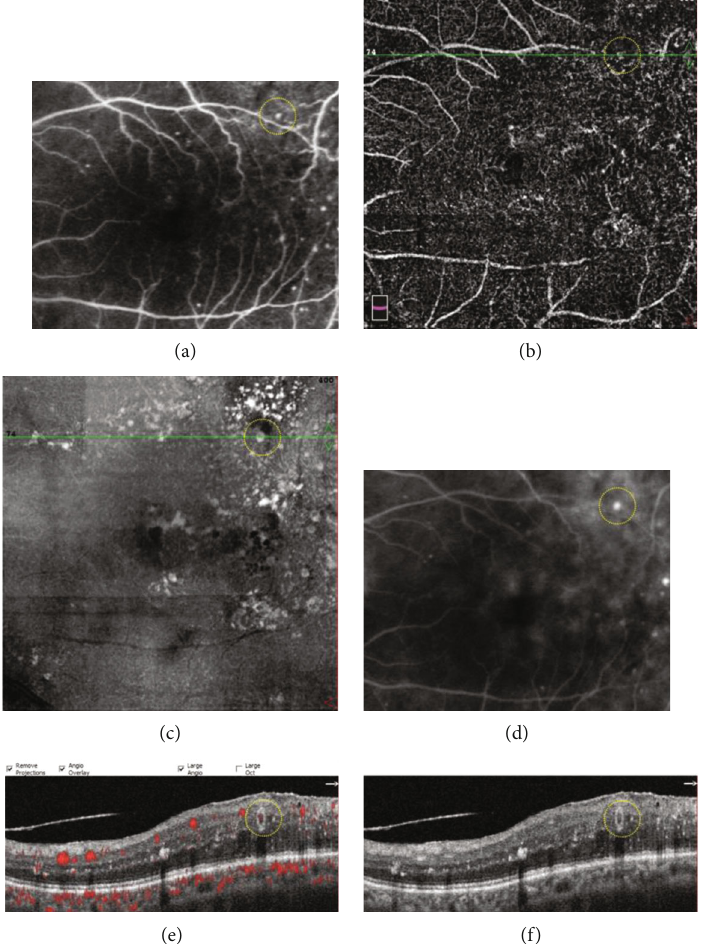
Figure 3: A typical diabetic microaneurysm with mild leakage on FA (yellow circle (a), early phase of FA (d), late phase of FA). The microaneurysm was visualized as comma-like type in OCTA en face image (yellow circle (b)). On OCT en face image, the microaneurysm appeared as a luminescent spot (yellow circle (c)). The microaneurysm was recognized an oval well-demarcated lesion on OCT B-scan (yellow circle (f)), and the fl ow proportion of the microaneurysm was 24.8% on OCT B-scan with fl ow overlay (yellow circle